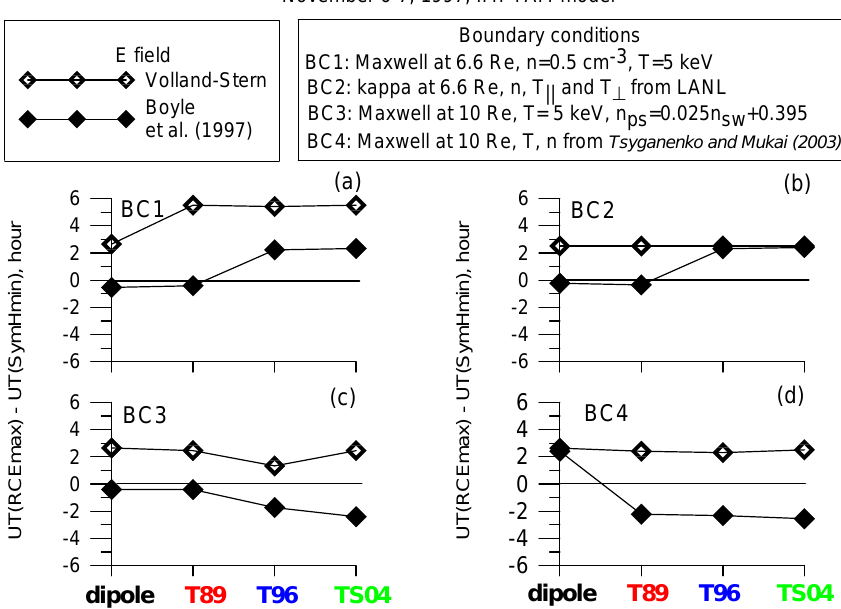
magnetic perturbation for direct comparison with